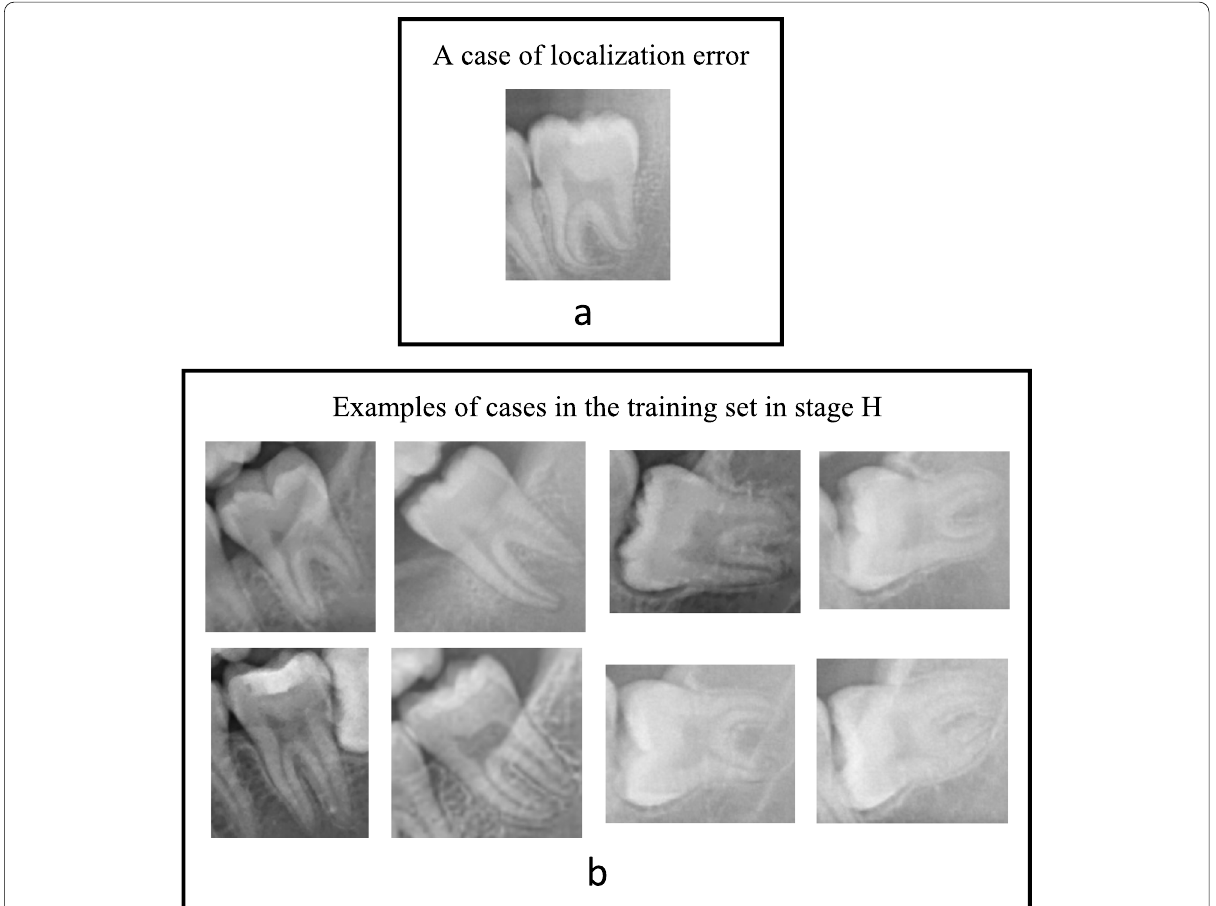
Fig. 3 A case of localization error in which the lower left third molar aligned vertically ( a ) and difference from others in the training set that were not vertically aligned ( b